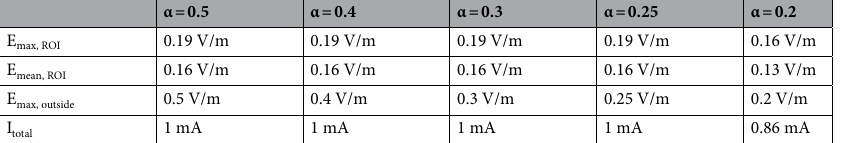
α = 0.5 α = 0.4 α = 0.3 α = 0.25 α =